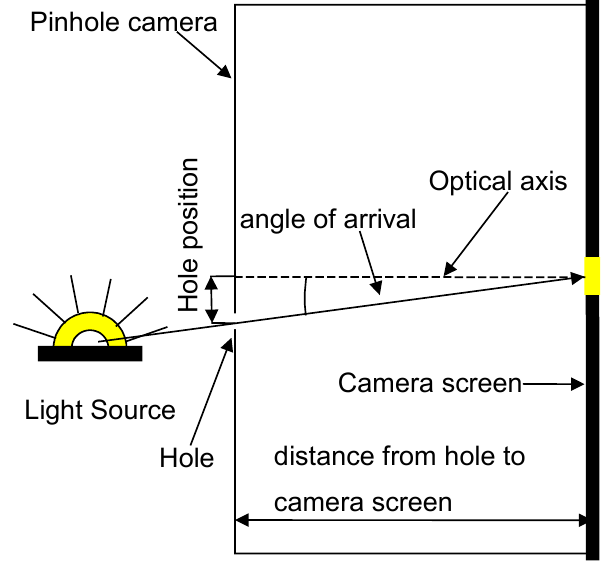
Figure 2. Angle of arrival determination with a modified movable hole pinhole